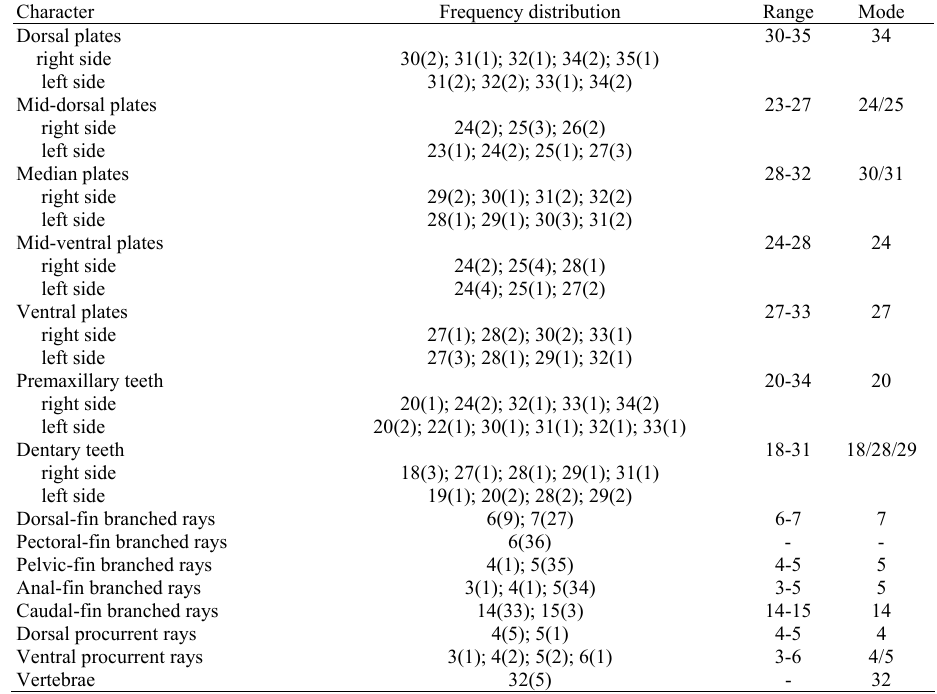
Table 4. Frequency distribution of meristics for Rhinolekos garavelloi (DZSJRP 10477, 12191; MCP 44057; MNRJ